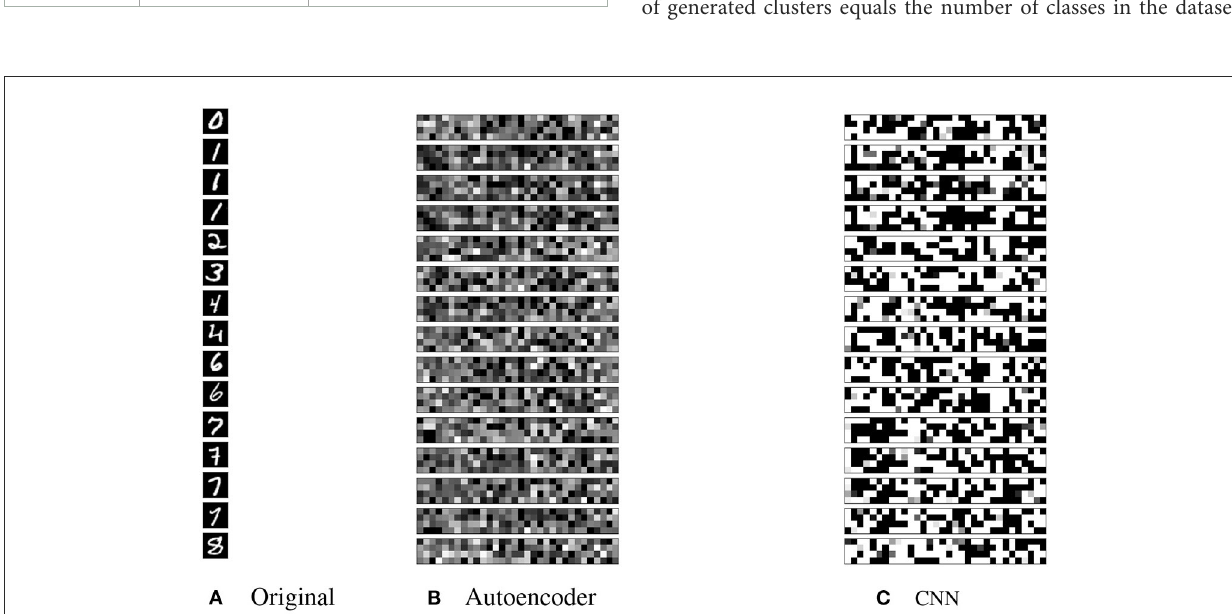
FIGURE6 (A) Selection of the original dataset; (B) the latent representations generated by the autoencoder; and (C) the latent representations generated by the CNN . Black is value 0 . 0, white is value 1 .